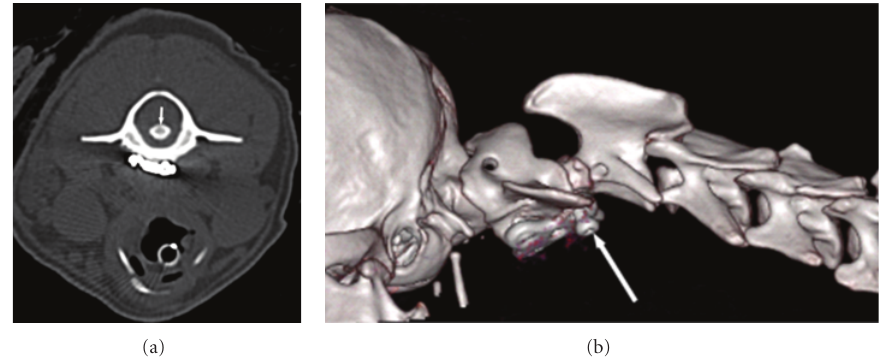
Figure 3: (a) Control CT scan after 2 years. The cyst appears not to have recurred; only a slight ventral cord compression elicited by the apex of the dens is visible (arrow). (b) Three-dimensional CT reconstruction showing the satisfactory positioning of the atlas and axis, and the loosening of the axial screws